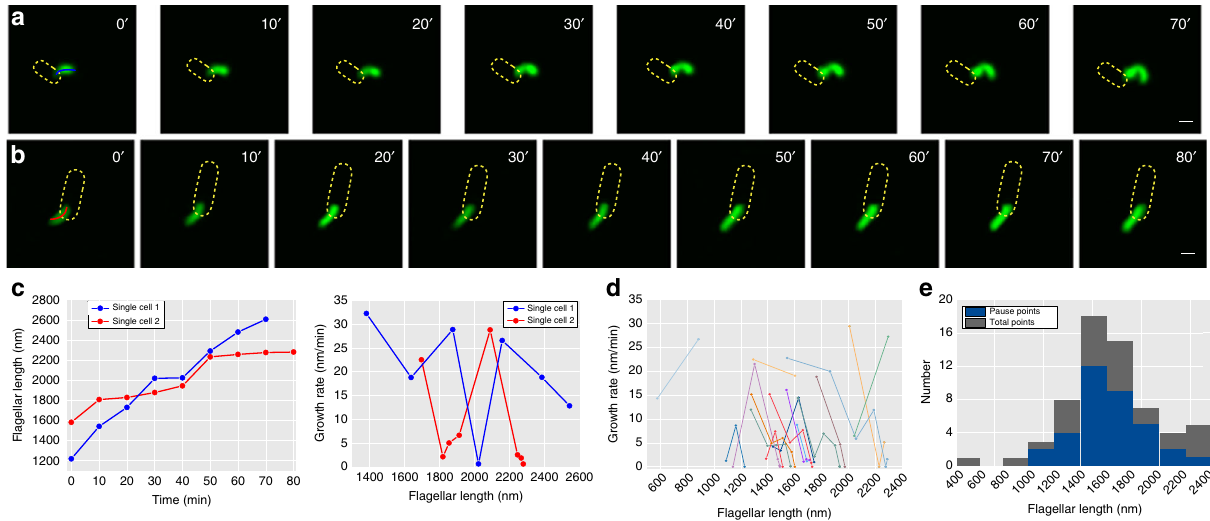
Fig. 3 Real-time time-lapse fl uorescence imaging of single fl agellar growth. a , b Continuous recording of a single growing fl agellum with images taken every 10 min. Other fl agella on the cell were removed to show the growing fl agellum more clearly. Scale bar = 1 µ m. c Plots of fl agellar length versus time and the fl agellar growth rates versus fl agellar lengths (Blue line: the fl agellum in a ; Red line: the fl agellum in b ). d More growth measurements of 16 individual fl agella tracked by real-time imaging. e Distribution of pause events (Blue) occurring in the total collected data points (Dark gray) at different fl agellar lengths, binned at 200-nm intervals. All data points are from the measurements in